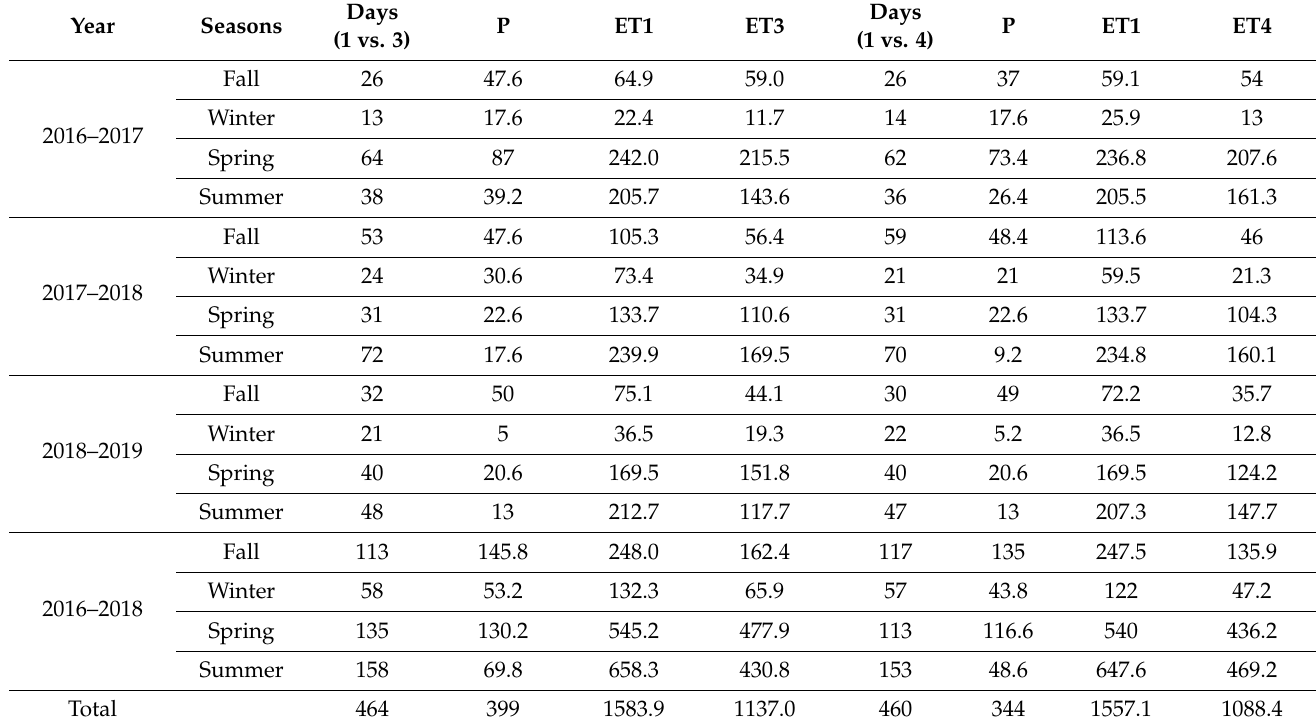
Table A7. Cumulative ET and P in mm for the lysimeters in common validated days for reference (lysimeter 1) and non-internal water storage configurations (lysimeters 3 and